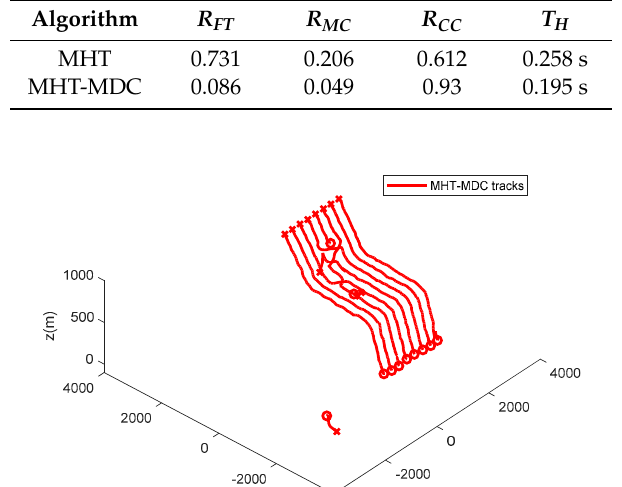
Table 3. The performance metrics of two algorithms in scenario 2.